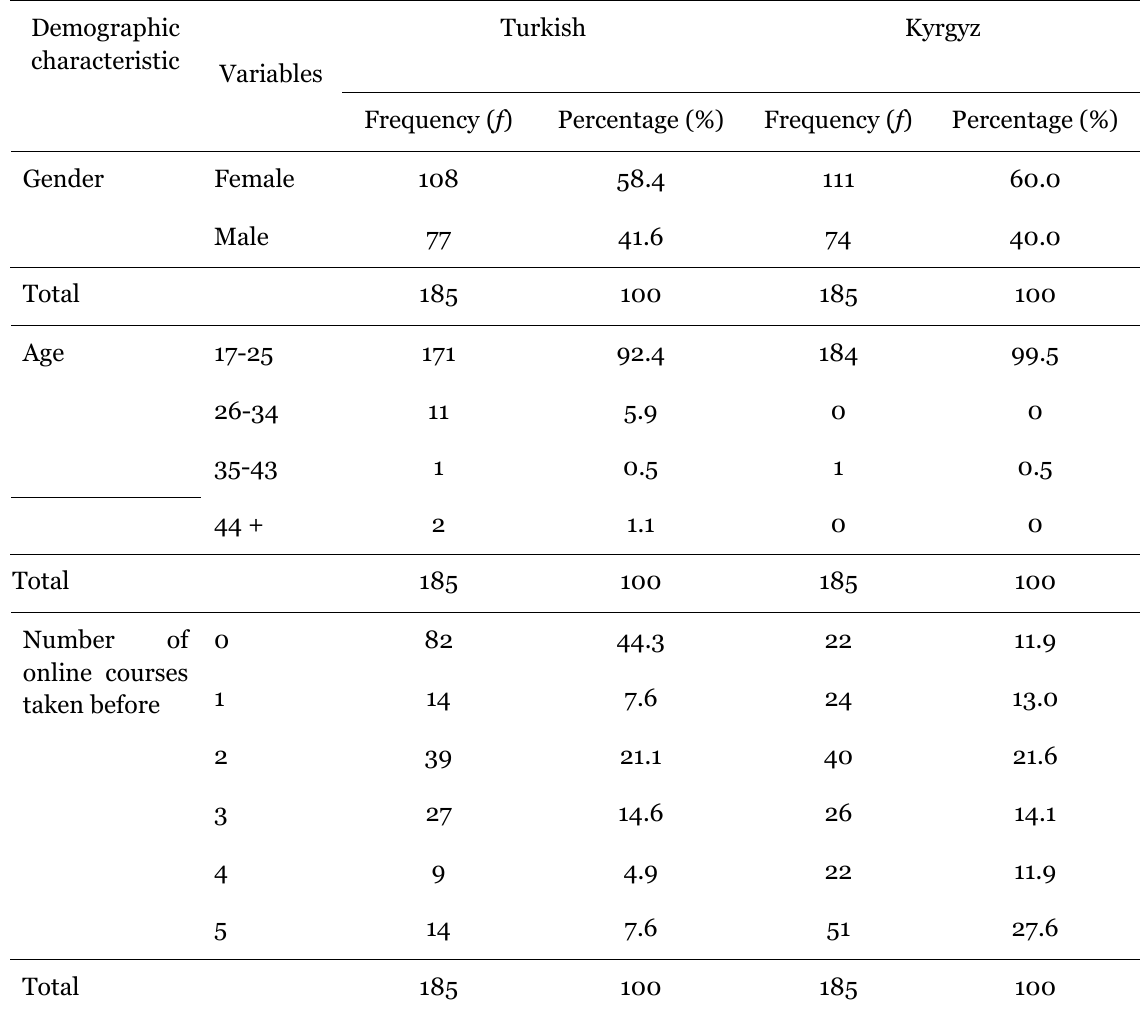
Analysis of Demographic Data of